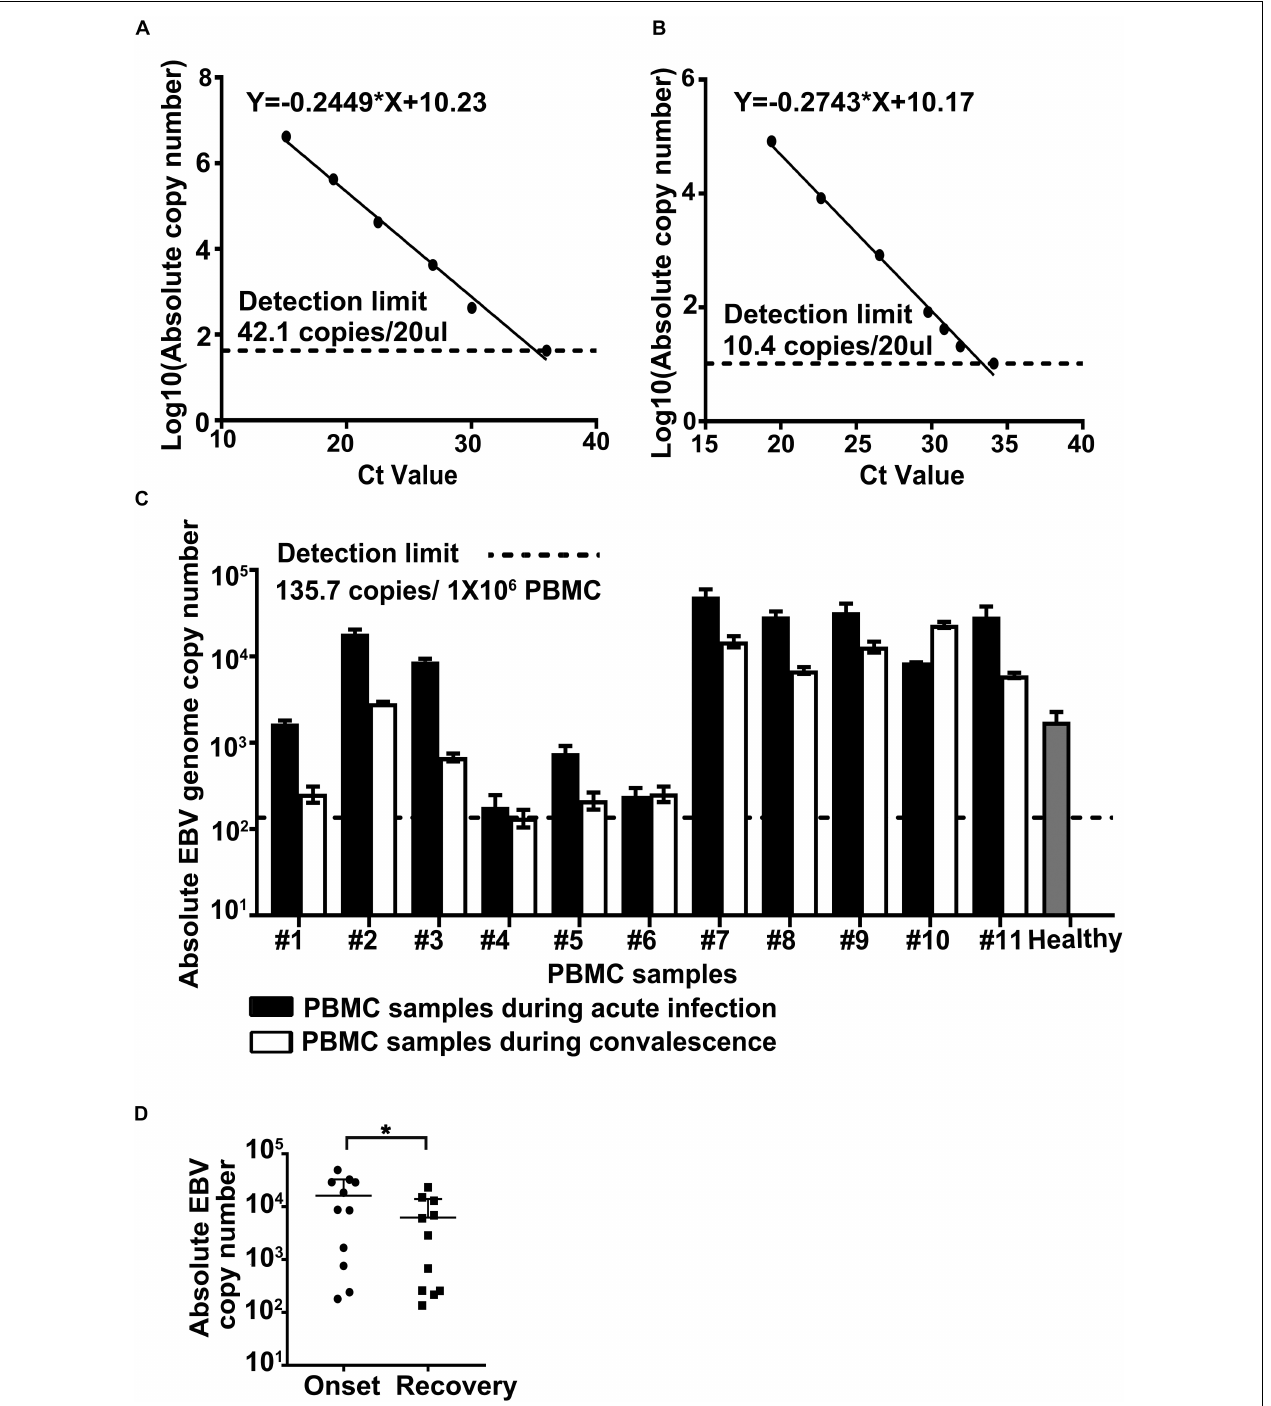
FIGURE 3 | Determination of Epstein–Barr virus (EBV) genome copy number in the peripheral blood mononuclear cells (PBMCs) from dengue patients. Plasmid containing Bam HI W region of EBV genome (A) or total DNA from Namalwa cells (B) served as reference standards in qPCR. Detection limits were given in exact numbers and marked by black dashed lines. Calculation equations were given on top of each chart. (C) Absolute EBV genome copy numbers in the PBMCs collected during the acute phase of dengue infection (the black column) or at the time of disease resolution or recovery (the white column) were determined by qPCR, as elaborated in section “Materials and Methods.” Cases 1–6 were in the non-elderly group, and cases 7–11 were in the elderly group. Healthy control (the gray column) was an average of EBV genome level in PBMCs collected from five individuals aged between 23 and 27 years. The statistical analysis of the EBV genome load in samples collected at the time of disease onset vs. that in samples collected at the time of recovery was shown in panel D , p = 0.0416.